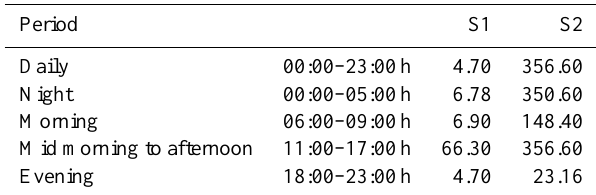
Table 1. Values of the slopes S1 and S2 obtained with the method- ology described by Rodr´ıguez and Cuevas (2007). S1 and S2 are expressed as 10 6 particles/ng